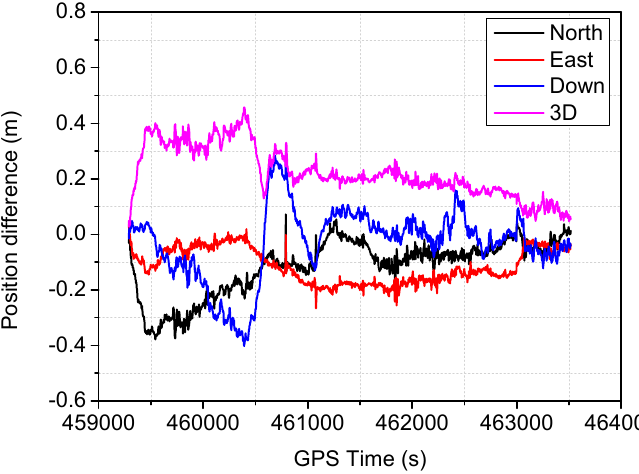
Figure 4. Position difference from the conventional PPP.